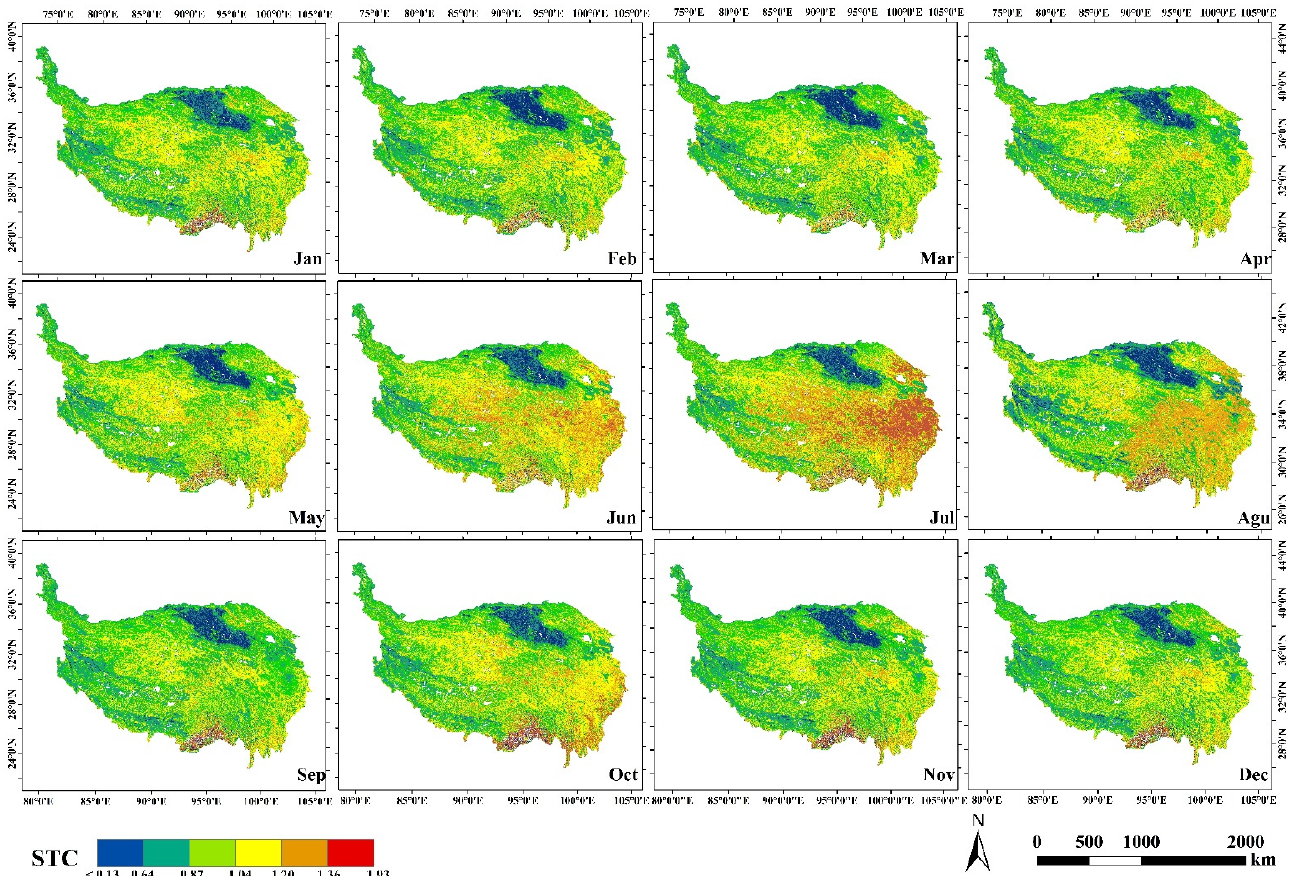
Figure 10. Monthly spatial distribution and variation characteristics of STC on the Qinghai–Tibet Plateau in 2018.